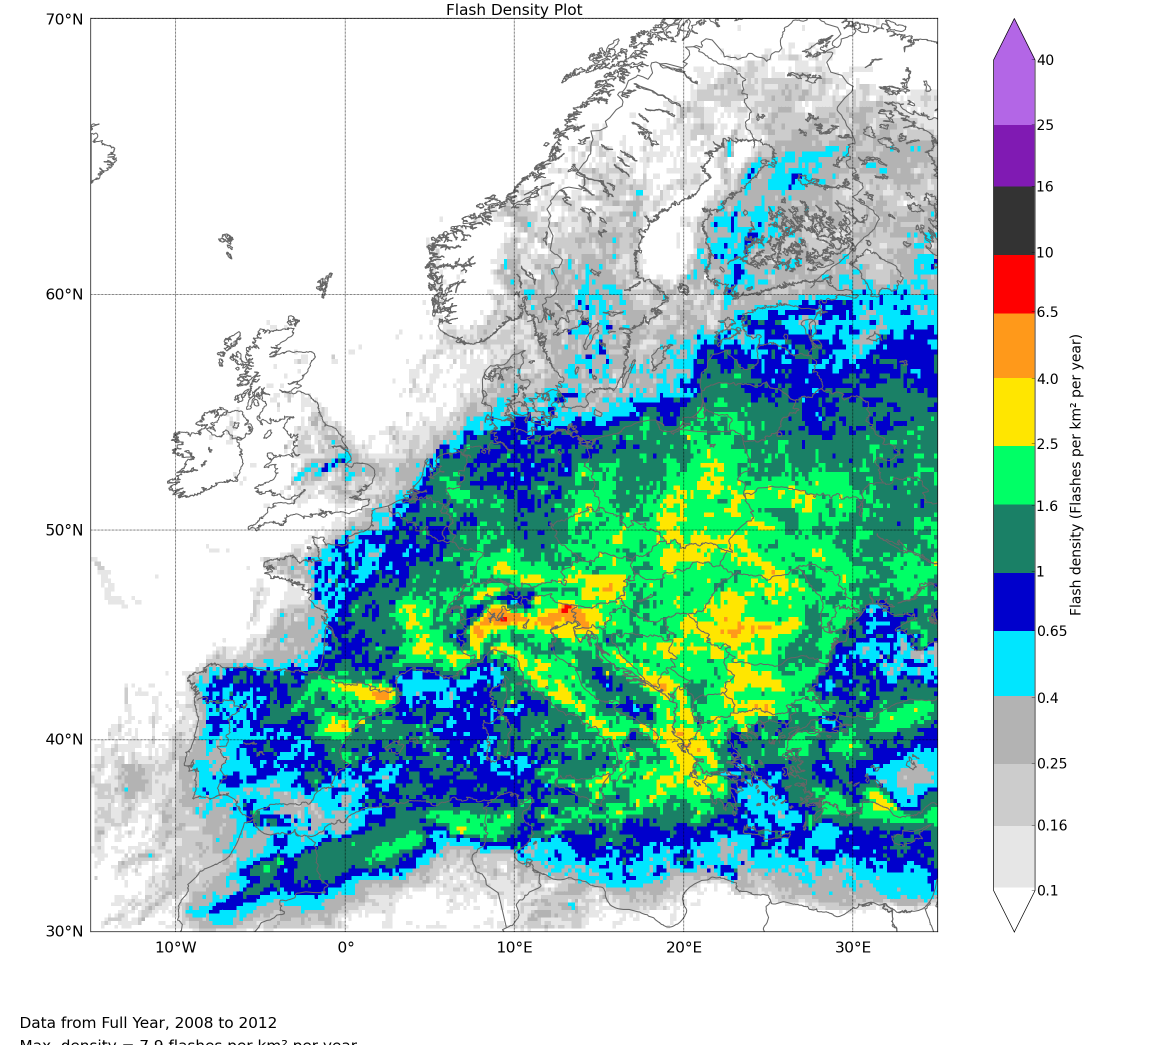
Fig. 4. Annual detected lightning flash